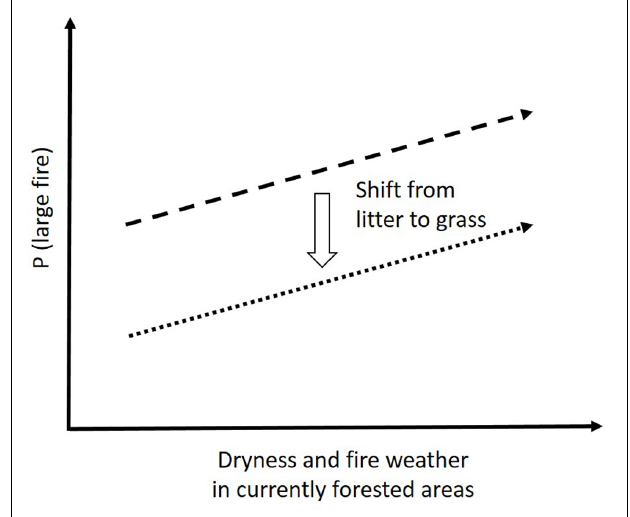
FIGURE 4 | Potential future trajectory of large fire risk in currently forested areas. Shifts from litter-dominated to grass-dominated fuels may lead to a decrease in fire probability, even as risk in both systems would rise in response to increasing dryness or fire